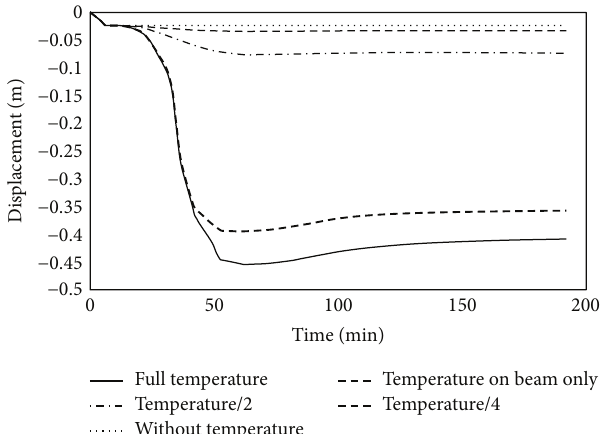
Figure 14: Shift diagram in the middle of the beam for connection to the bolted cover plate.